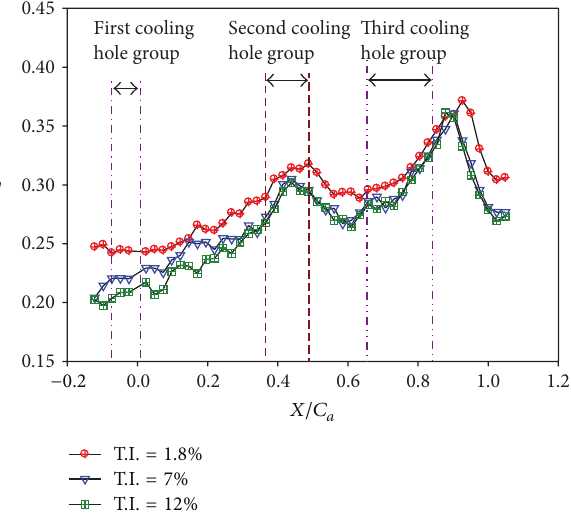
Figure 21: Effect of turbulence intensity on averaged effectiveness for forward-facing stepped endwall (Re = 124000 , 𝑀 = 2 , and 𝑆/𝐶 = 4